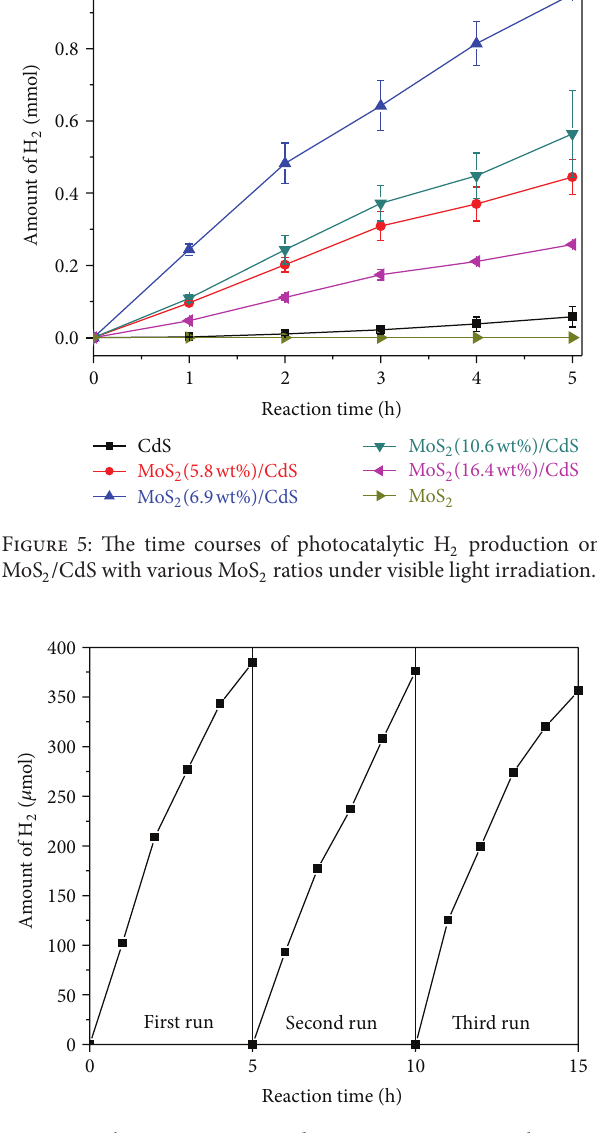
Figure 6: Three consecutive cycling experiments using the same MoS 2 (6.9 wt